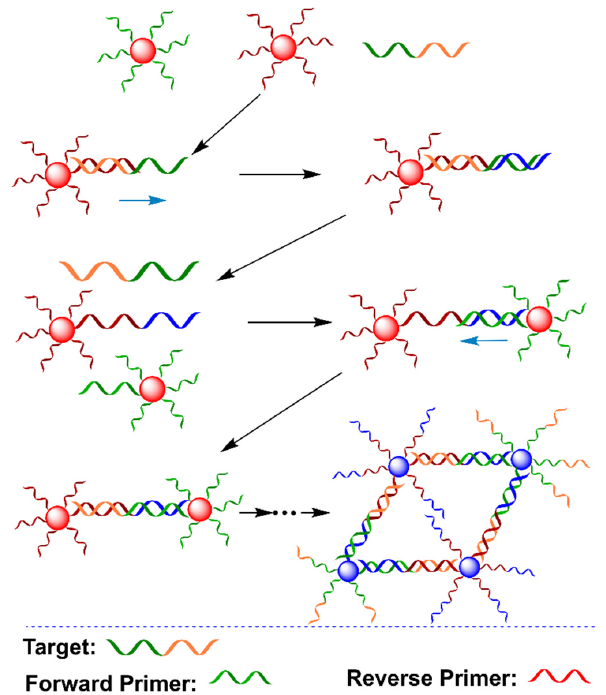
Figure 7. Schematic diagram of a colorimetric PCR method for a specific DNA based on primer- modified AuNP probes. Adapted with permission from ref [83]. Copyright 2010 Springer Nature.